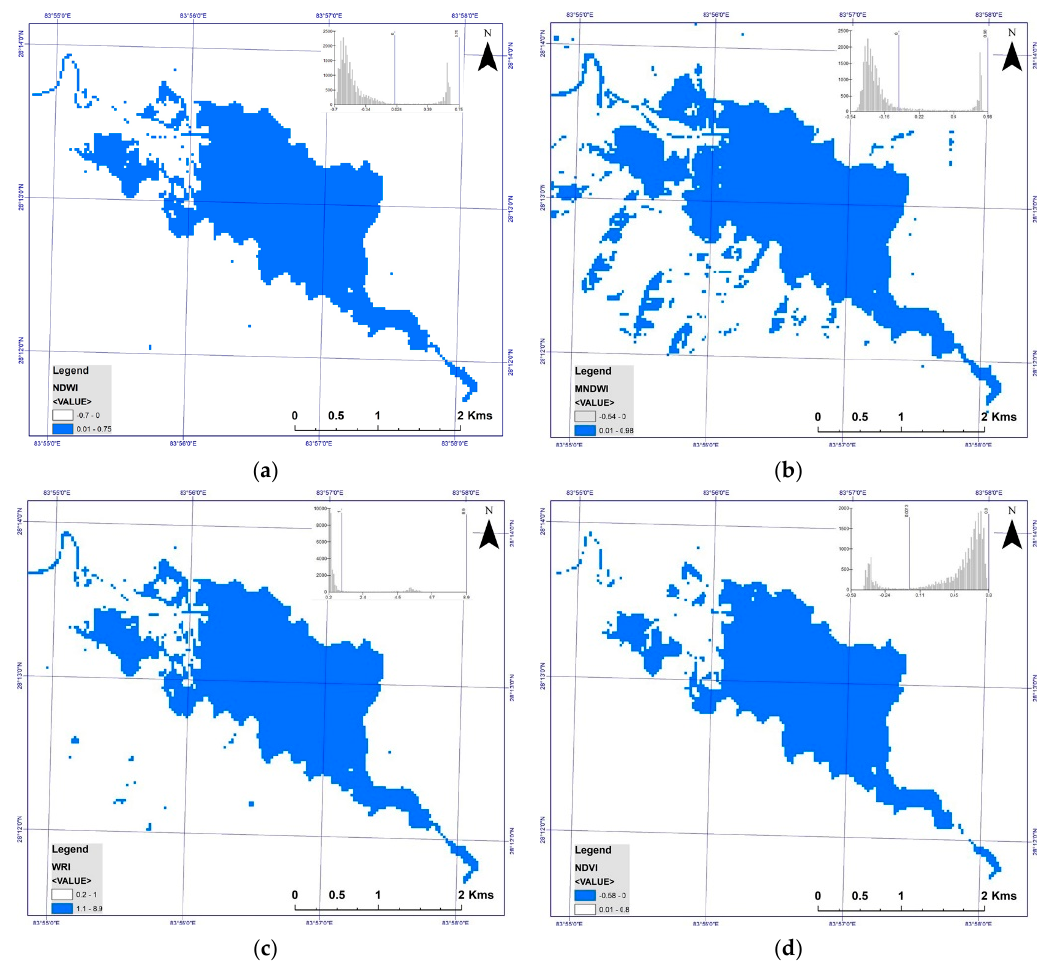
Figure 3. Water bodies from Landsat 8 OLI image: ( a ) NDWI; ( b ) MNDWI; ( c ) WRI; ( d )